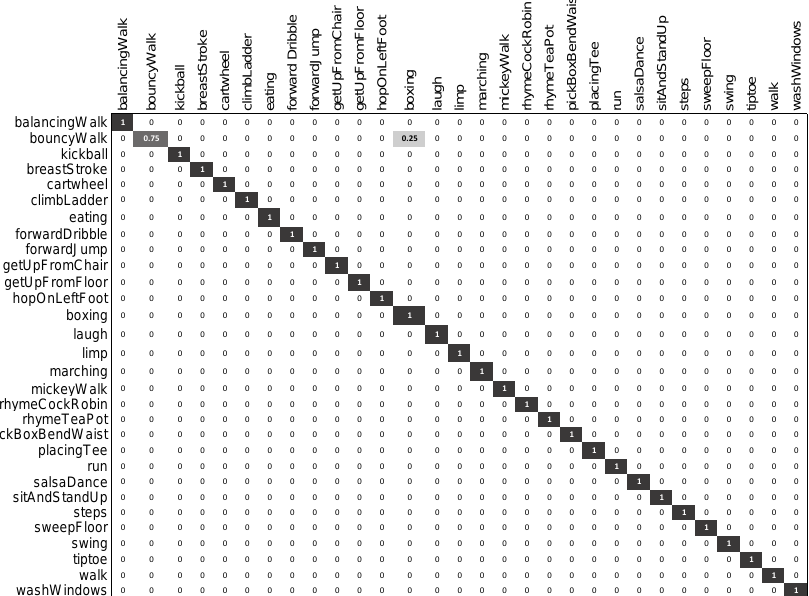
Figure 8. Confusion matrix of our proposed approach on the CMU-30 dataset.